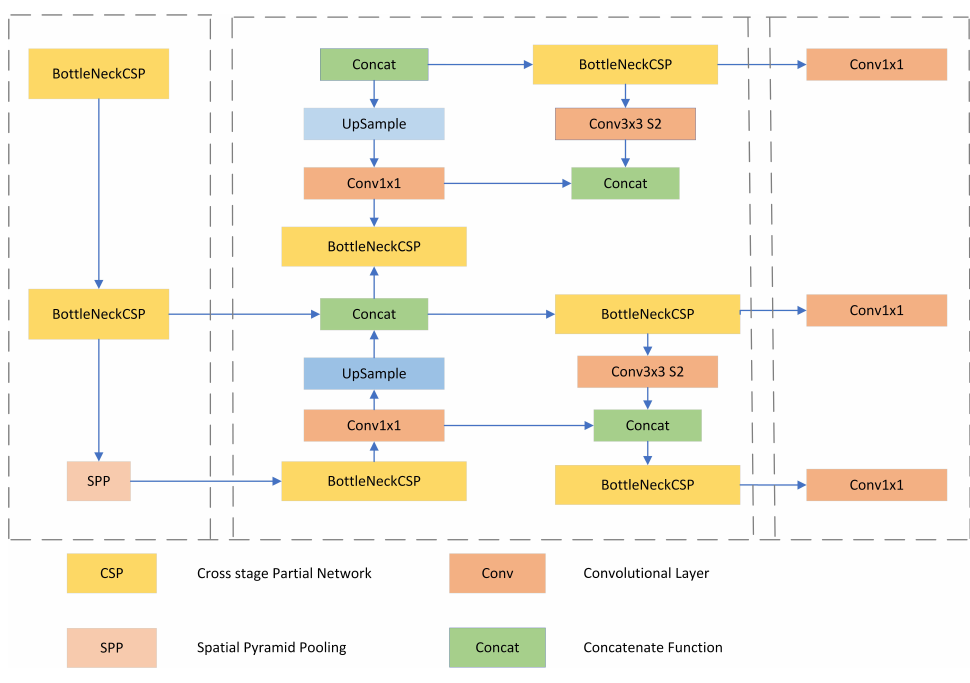
Figure 5. The architectural diagram of the YOLOv5